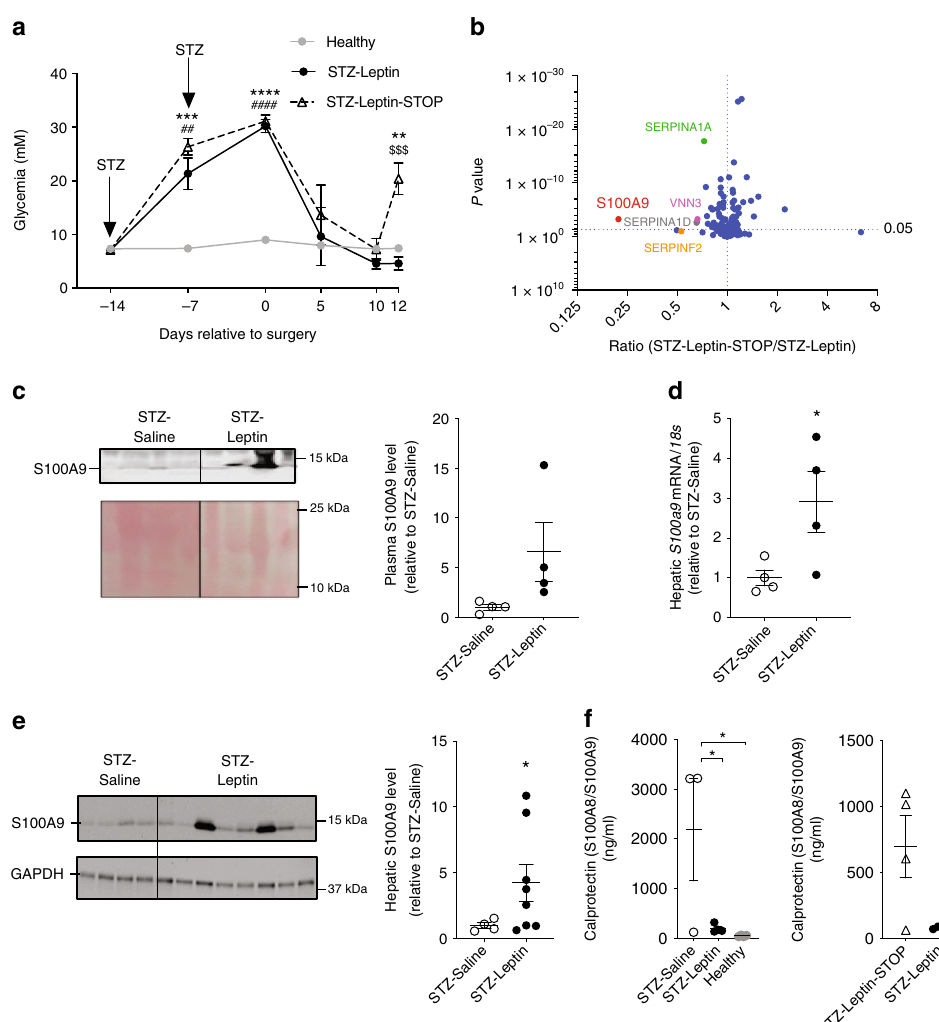
Fig. 1 S100A9 is a leptin-induced cue. Intracerebroventricular (icv) delivery of leptin was performed in two groups of STZ-treated, insulin-de fi cient mice: STZ – Leptin mice received leptin for 12 days; STZ – Leptin – STOP mice received the hormone for 10 days and were followed up to day 12. icv surgery was performed at day 0 and STZ injections were performed 14 and 7 days before surgery. a Blood glucose level in STZ – Leptin and STZ – Leptin – STOP mice. The gray line represents average values measured in age-matched non-diabetic healthy control mice. Twelve days after icv surgery, blood samples from STZ – Leptin and STZ – Leptin – STOP were collected and assessed for quantitative proteomic analysis. b Volcano plot representing the quantity of each circulating protein detected in STZ – Leptin – STOP divided by the quantity of each respective protein in STZ – Leptin mice. c S100A9 content in plasma. d S100a9 mRNA levels. e Western blot showing protein content in liver from a cohort of STZ-treated, insulin-de fi cient mice that underwent either icv leptin or icv saline treatment for 12 days. f Calprotectin content in plasma of STZ – Saline, STZ – Leptin, and their healthy controls and in STZ – Leptin and STZ – Leptin – STOP mice. Error bars represent SEM. For all panels n = 4/ group, except quanti fi cation in e that is from four STZ – Saline and eight STZ – Leptin mice. Statistical analyses were done using a two-tailed unpaired Student ’ s t- test when two groups were compared, and one-way ANOVA or two-way ANOVA (Tukey ’ s post hoc test) when more than two groups and more than one experimental condition/time point were compared, except in e where Welch ’ s t -test was used. In a **** P < 0.0001, *** P < 0.001, and ** P < 0.01 STZ – Leptin – STOP vs Healthy; #### P < 0.0001 and ## P < 0.01 STZ – Leptin vs. Healthy; $$$ P < 0.001 STZ – Leptin – STOP vs Leptin. In c – f * P < 0.05. Western blot results shown in c , e are cropped images of the whole gel. Source data are